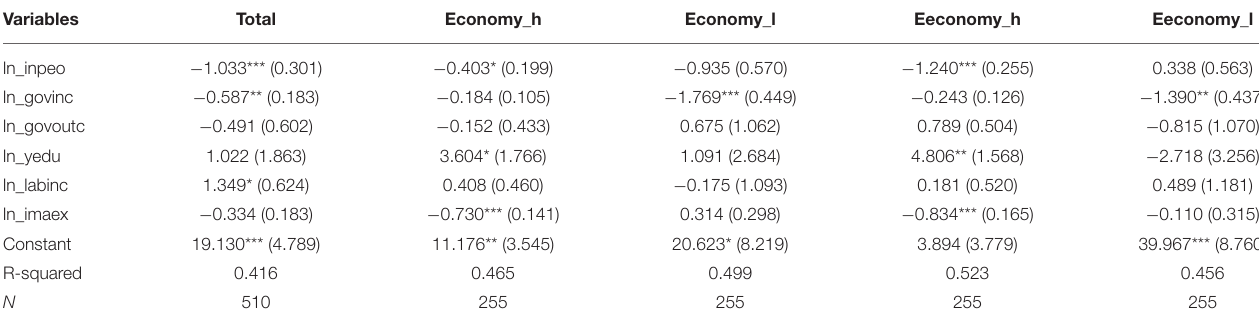
TABLE 3 | The result of pannel regression.